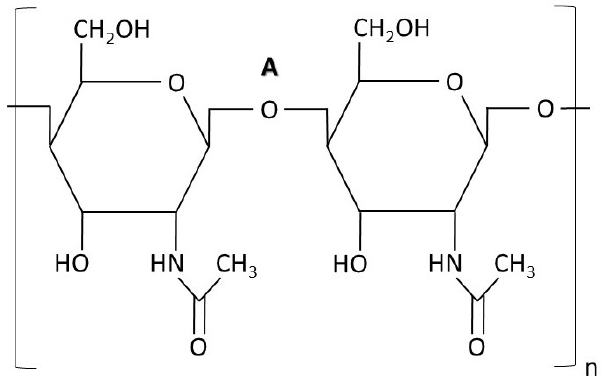
Figure 3. Chitin structure of polymerized N-acetylglucosamine monomers with ( A ) β -1,4 linkages.